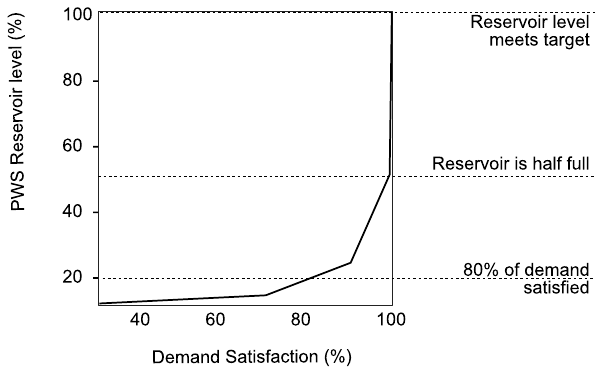
Figure B1. Public water supply company hedging